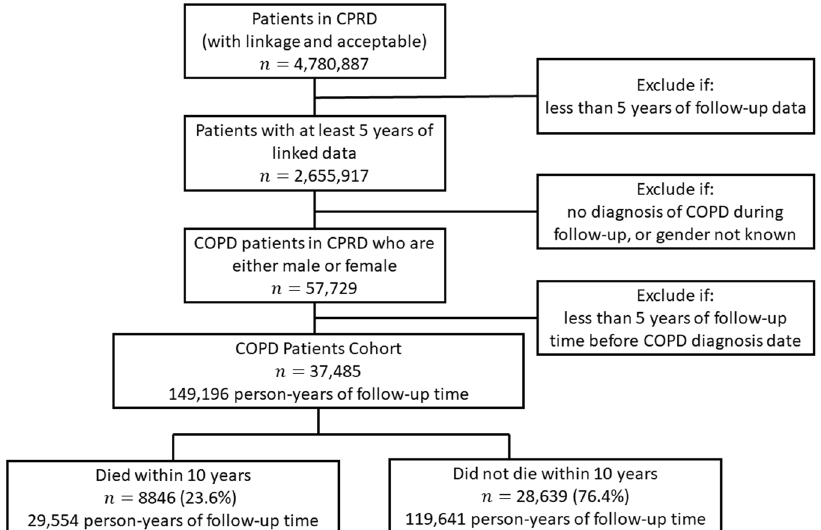
Fig. 3 Patient fl ow diagram. Patient fl ow diagram with the number of patients with and without the outcome, and a summary of the follow- up time.